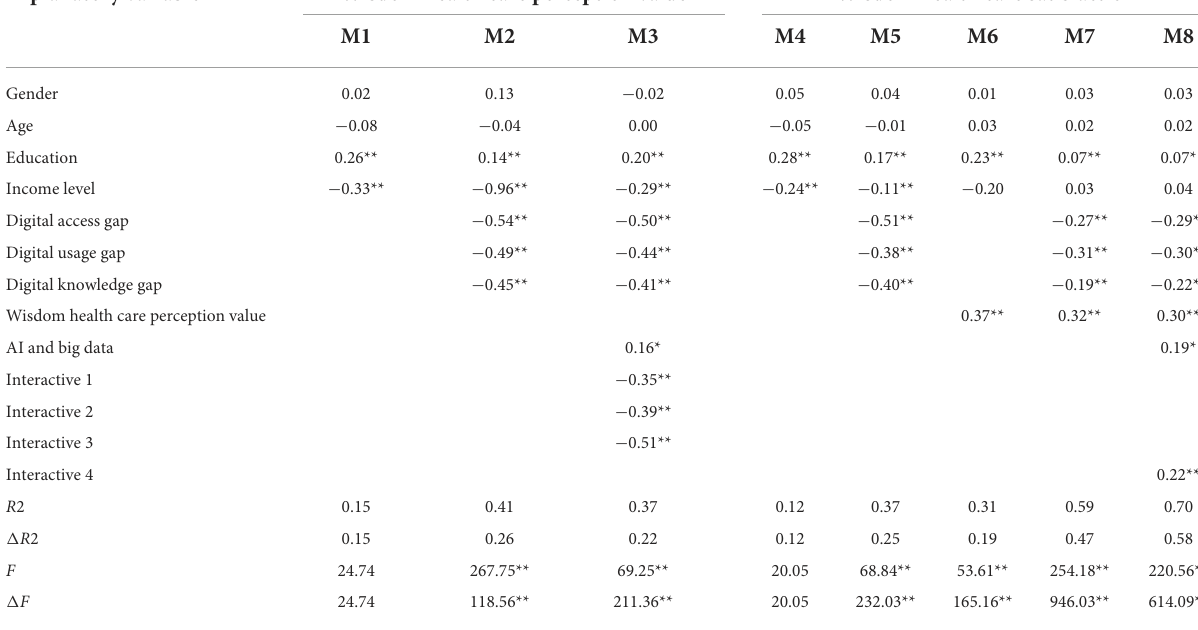
TABLE 3 Hierarchical regression results. Explanatory